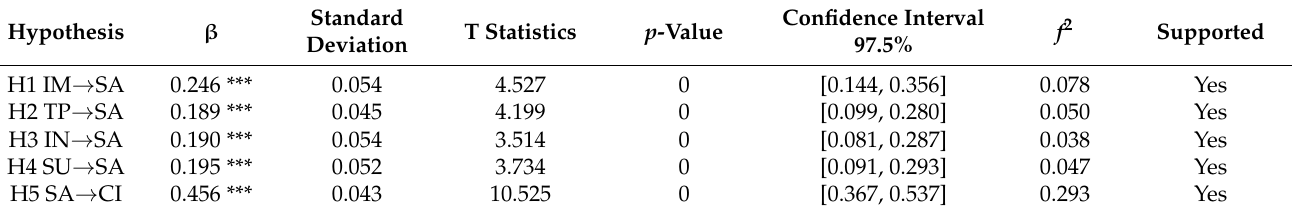
Figure 2. PLS result of research model testing (N = 475). Note: *** p -value < 0.001; ns, not significant. Table 6. Structural path analysis results.